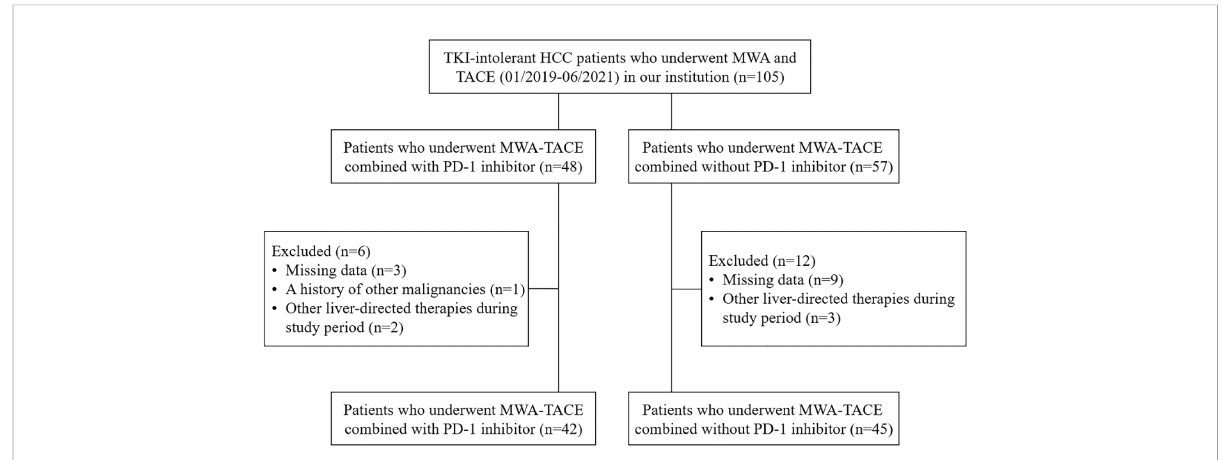
FIGURE 1 Flow diagram of patient enrollment. HCC, hepatocellular carcinoma; MWA, microwave ablation; TACE, transarterial